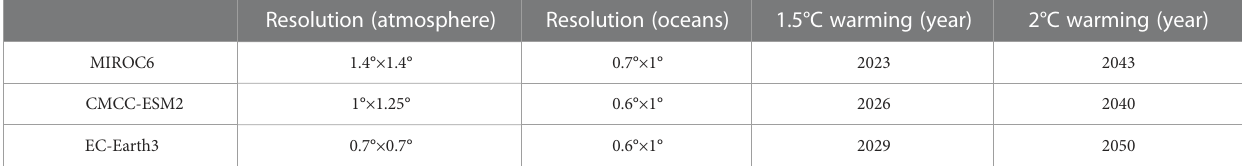
TABLE 2 The selected CMIP6 simulations and projected year of